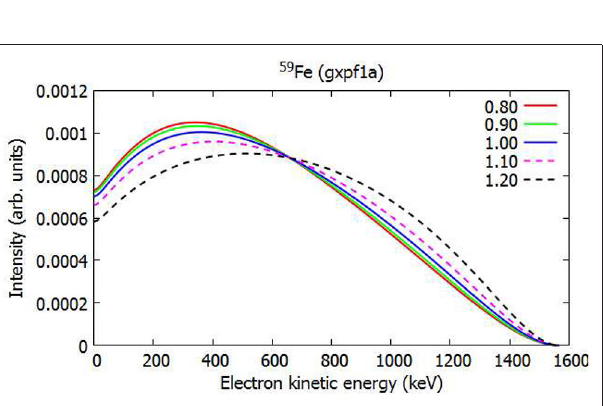
FIGURE 12 | Normalized ISM-computed electron spectrum for the second-forbidden non-unique β − decay of 59 Fe. The value g V assumed and the color coding represents the value of g A